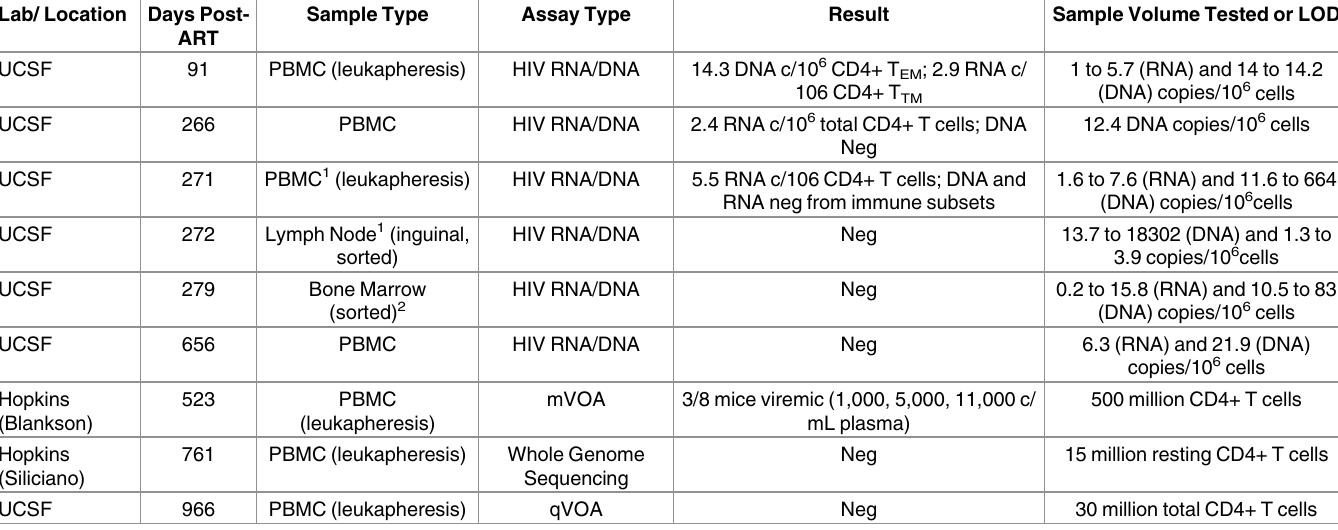
1 DNA and RNA obtained from sorted CD4+ T cell immune subsets (T N , T CM , T EM , and T TM ). 2 DNA and RNA obtained from sorted CD4+ T cells, common lymphoid progenitor cells, hematopoietic stem/progenitor cells, and myeloid cells. Abbreviations: ART, antiretroviral therapy; c/mL, copies/mL; GALT, gut-associated lymphoid tissue; LOD, limit of detection; Neg, negative; PBMC, peripheral blood mononuclear cells; PrEP, pre-exposure prophylaxis; qVOA, qVOA, quantitative viral outgrowth assay; UCSF, University of California San Francisco.